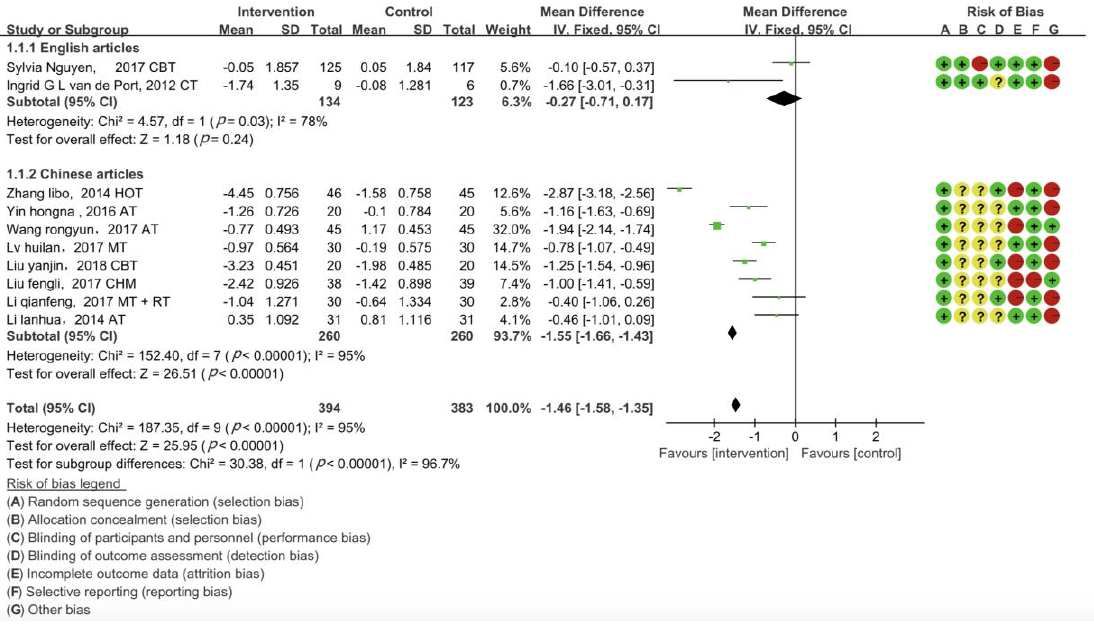
Figure 3. Forest plots and assessment of risk of bias. Horizontal lines correspond to study-specific MD and 95% CI. The area of the square reflects study-specific weight. The diamond represents pooled results of MD and 95% CI. (1.1.1) Articles in English and (1.1.2) Articles in Chinese. For each study, the selection bias, performance bias, detection bias, attrition bias, reporting bias, and other biases were assessed at “low risk” if shown in green, “unclear risk” if shown in yellow, and “high risk” if shown in red.